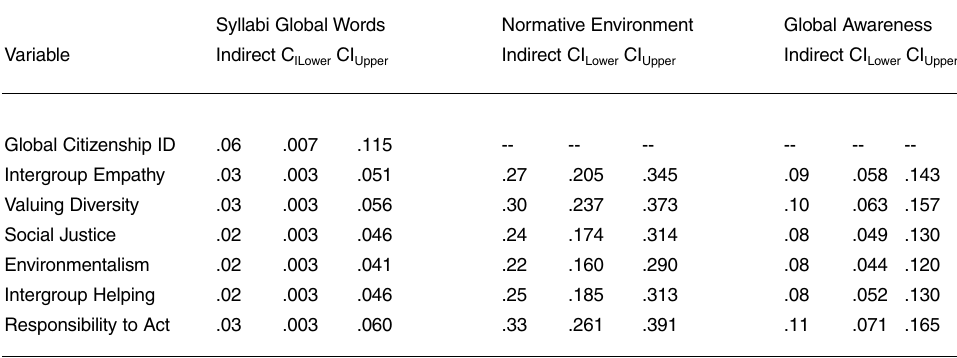
Table 2: Indirect Effects of Syllabi Global Citizen Word Count, Normative Environment, and Global Awareness Syllabi Global Words Normative Environment